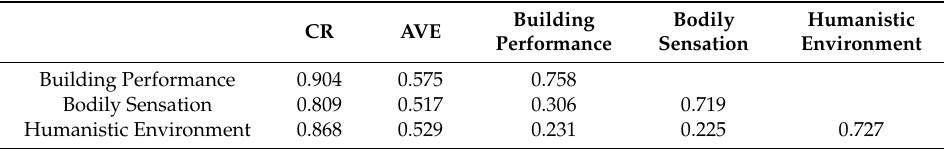
Table 3. Parameters of convergent and discriminant validity.